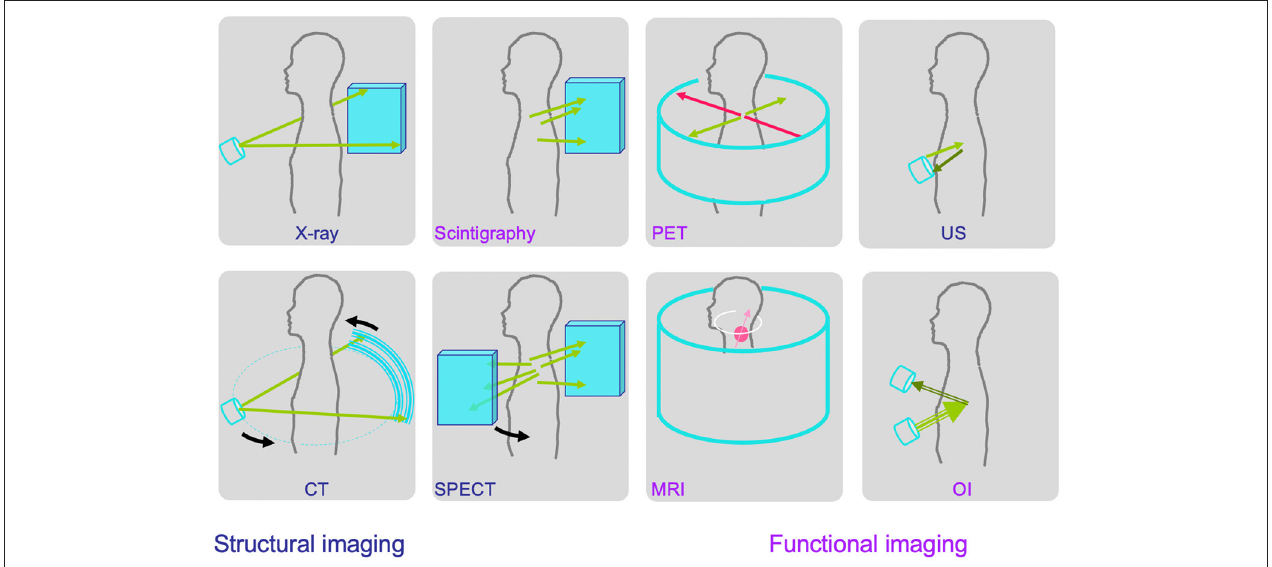
FIGURE 3 | Basic principles of key imaging modalities that fall into the categories of structural (anatomical) and functional (metabolic) imaging as indicated in blue and purple, respectively: X-ray and computed tomography (CT) transmission imaging, nuclear medicine scintigraphy, positron emission tomography (PET) and single photon emission computed tomography (SPECT), ultrasound (US), optical imaging (OI), and magnetic resonance imaging